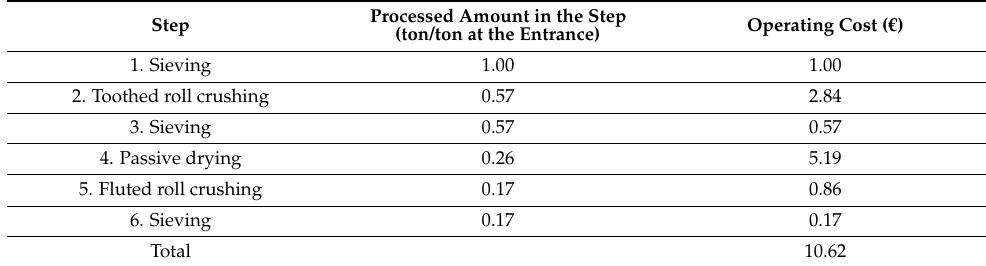
Table 9. Details of operating costs calculation based on the mass balance of the ALS sediment deagglomeration